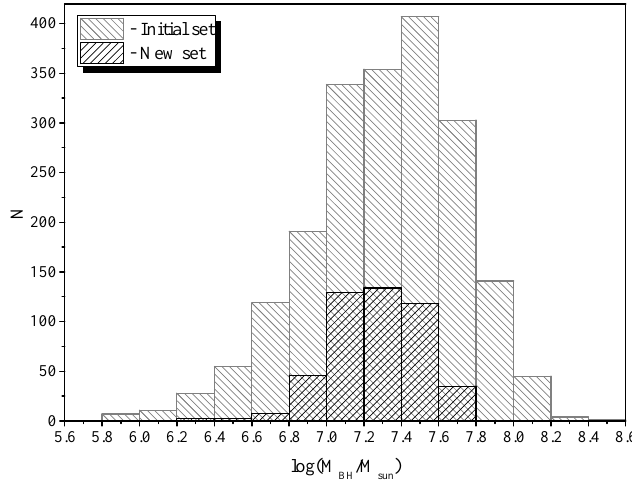
Figure 6. The distribution of the SMBH mass for the initial and new sets.